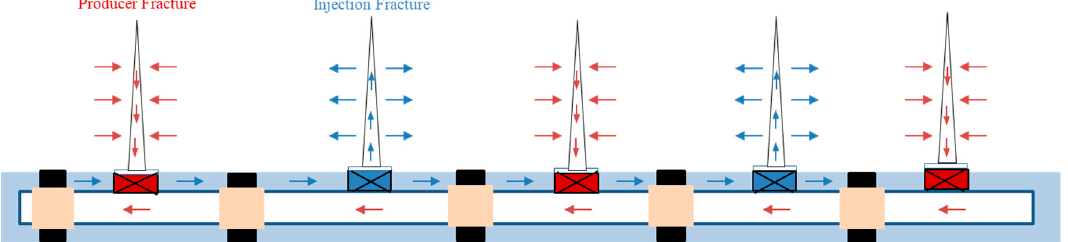
Figure 1. Sketch of Cumulative In-situ Injection and Production (CIIP).